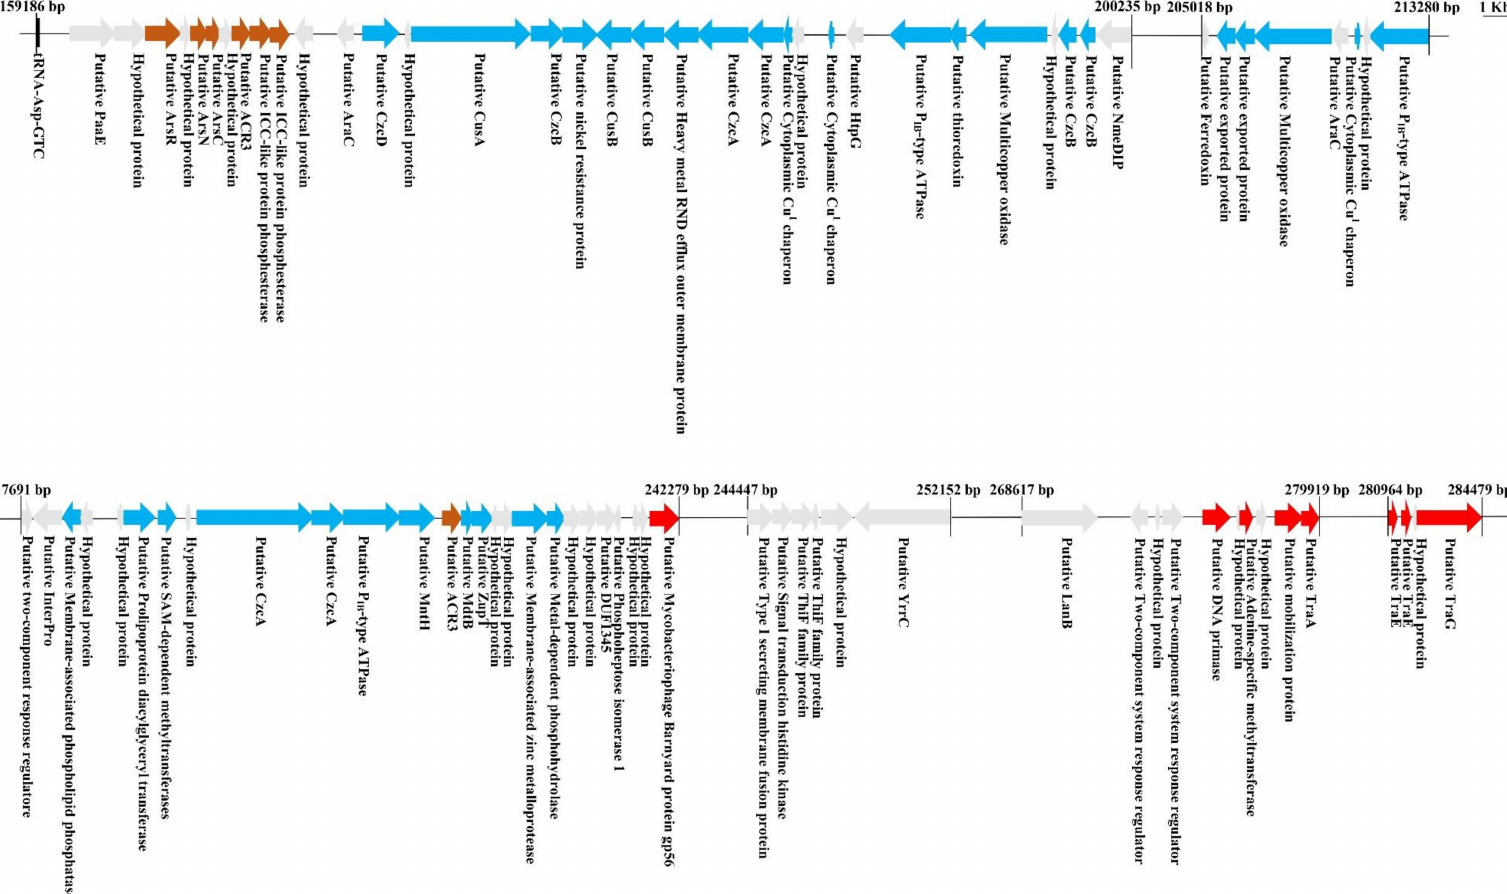
Figure 2. Representative putative genomic island carrying genes encoding HM determinants in contig 26 of M. Rubeus P2. Genomic analysis was performed via RAST (http://rast.nmpdr.org/). Genes encoding determinants related to metalloid (Arsenical and Antimony) resistance are highlighted in maroon, metal (Copper/Cobalt/Cadmium/Zinc/Lead/Mercury) resistance in blue, and the genes encoding putative transfer functions in red. Genes encoding hypothetical proteins and unknown functions are highlighted in